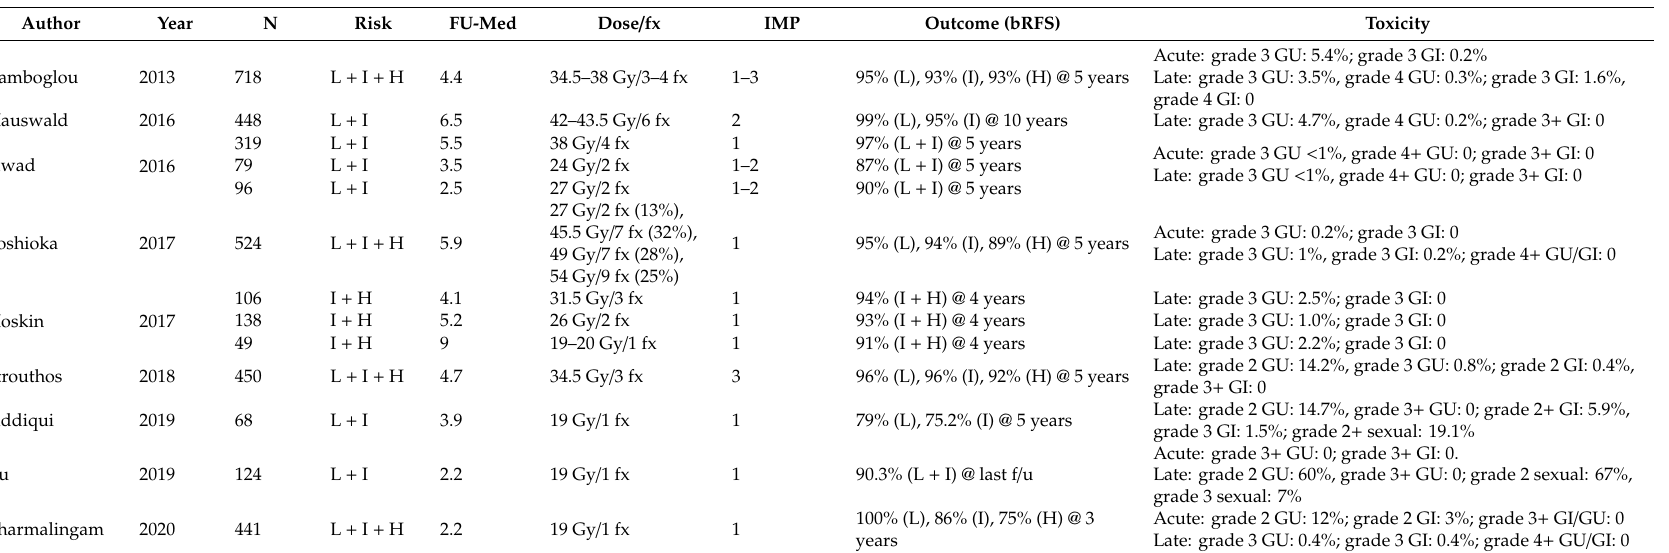
Table 2. Selected HDRBT monotherapy